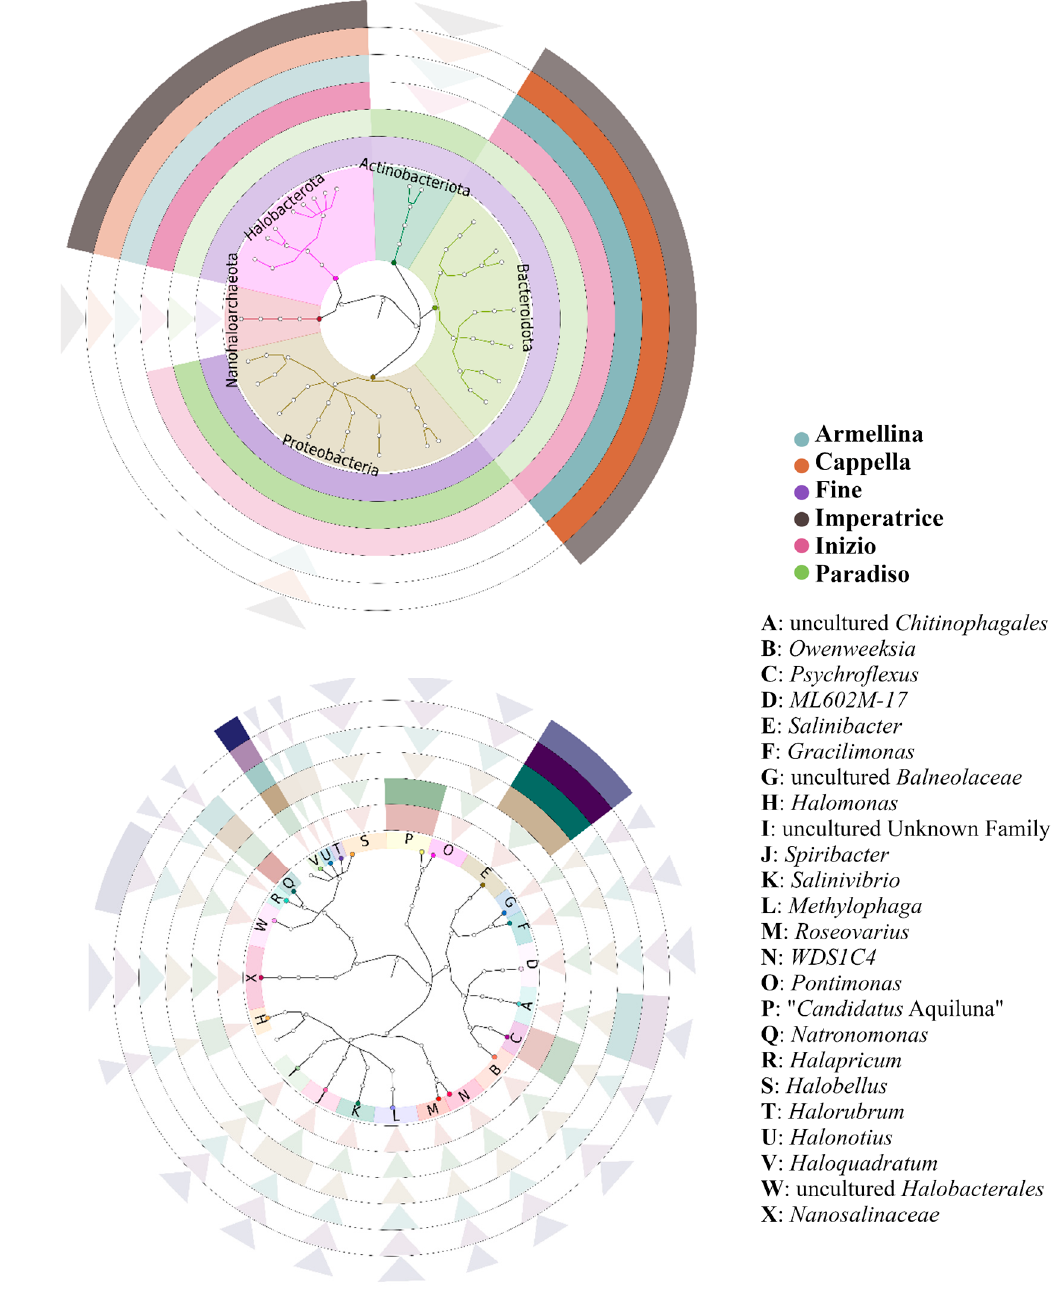
Figure 7. Phylogenetic graphs correlating identified phyla and genera and their abundances. Inside each graph, taxonomic trees are reported with full circles to indicate identified phyla (above) and genera (below). Names of phyla are reported inside the graph; names of genera are indicated in the side legend. Ponds are represented by external rings corresponding (from inside to outside) to increasing salinity. Their names are reported in the side